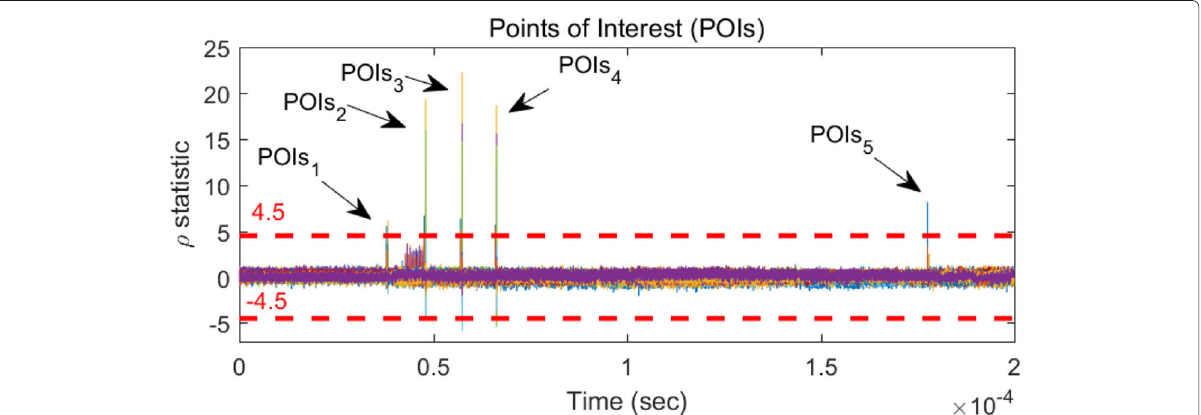
Fig. 10 The experimental results of ρ -test in T 32 G - S 1 G encryption mode. Point of Interest (POI) represents the point-in-time at which leakage